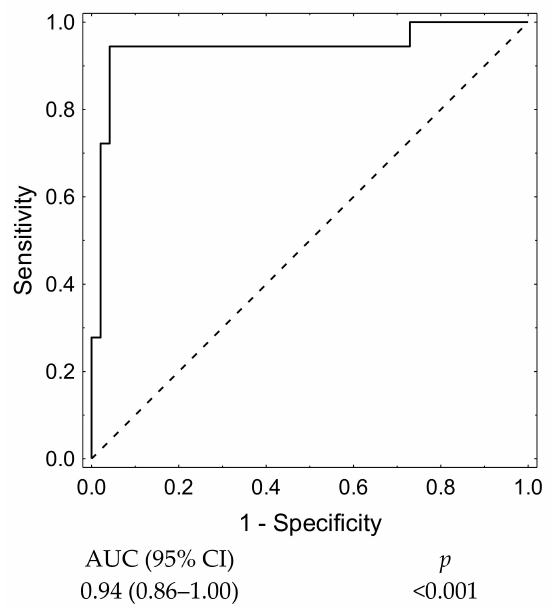
Figure 4. 1st VPD receiver operating characteristic (ROC)